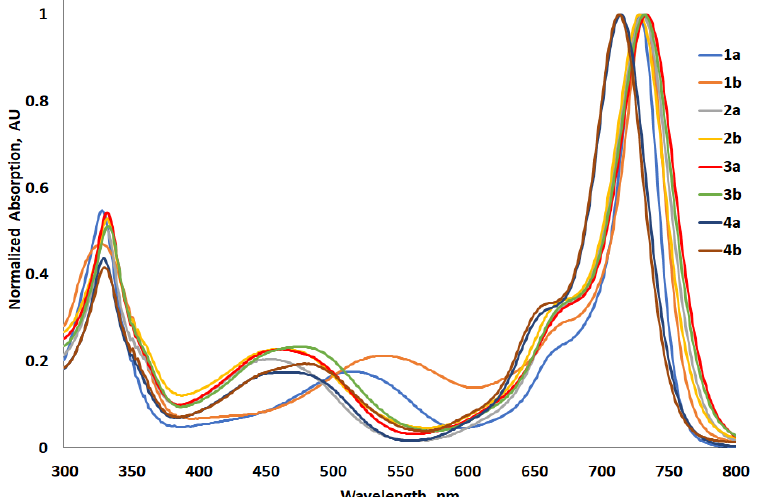
Figure 6. Absorption spectra of 1a-b , 2a-b , 3a-b , and 4a-b in DMSO. All spectra are recorded at a concentration of 10